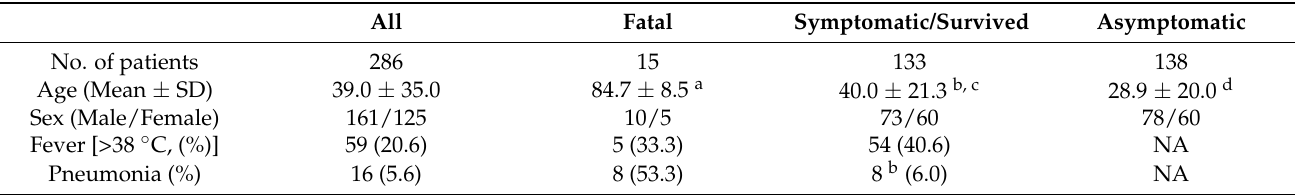
Table 1. Demographic data of the present